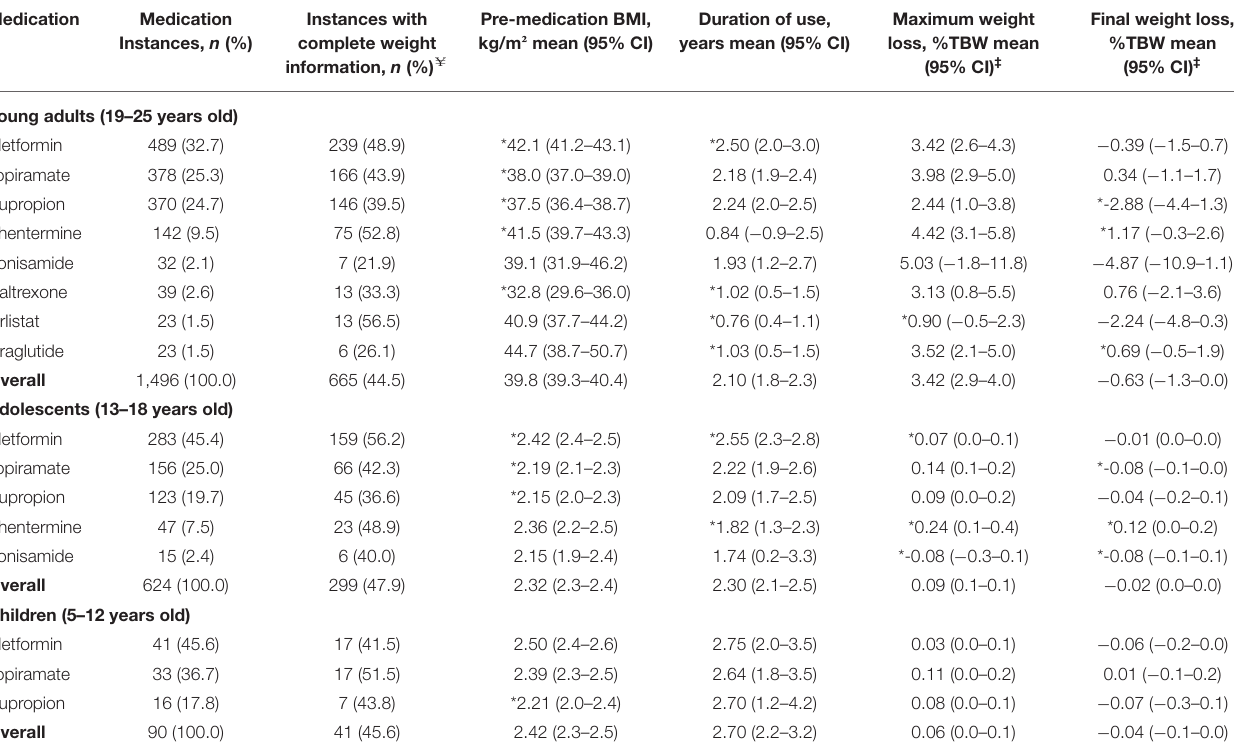
TABLE 5 | Medication characteristics and effect on weight loss, all patients - unadjusted